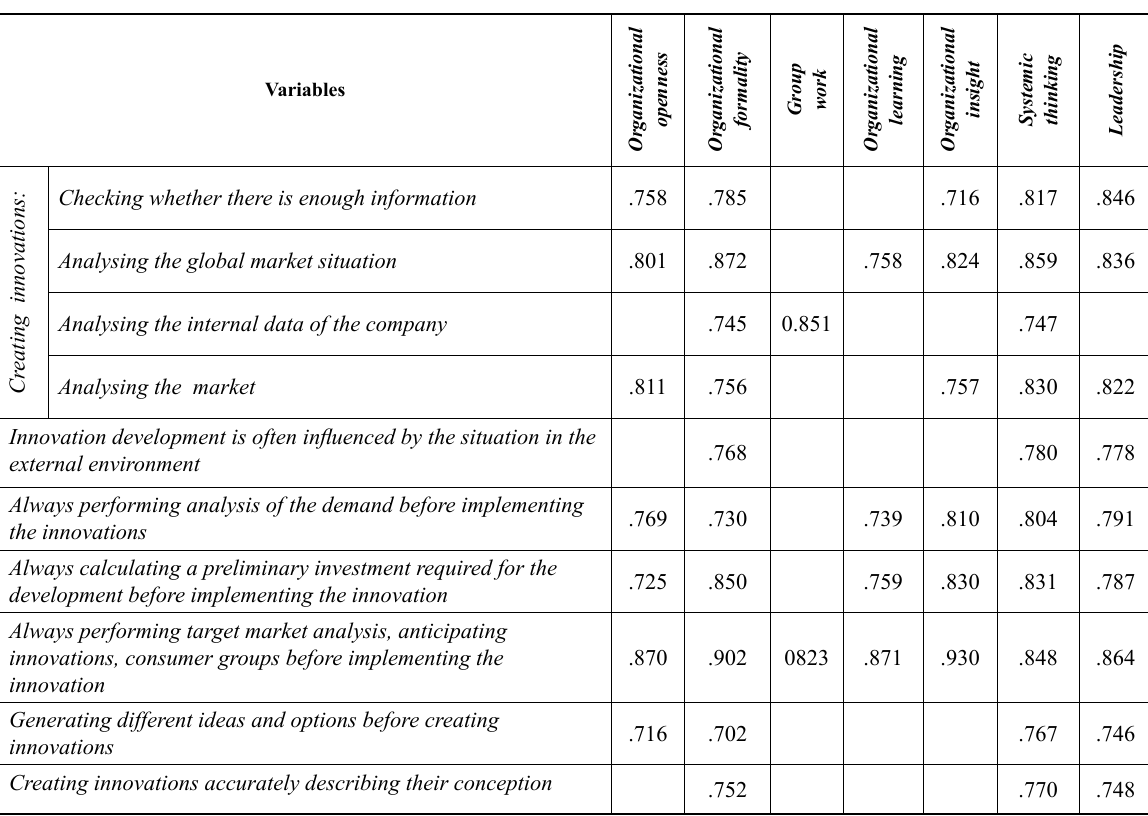
Table 1. Correlation matrix: preparation for innovations vs OI